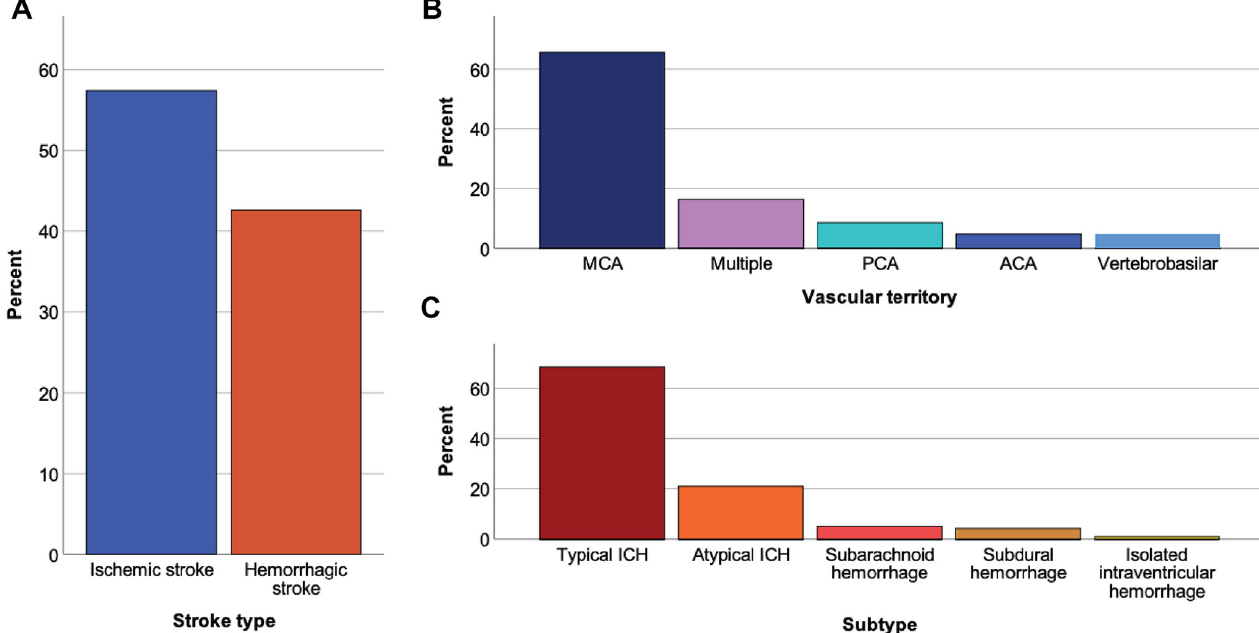
Fig 2. Radiological classification of ischemic and hemorrhagic stroke types. Panel A depicts the distribution to ischemic vs. hemorrhagic stroke as percentage of all strokes, panel B and C show distribution of vascular territories and stroke subtypes separately for ischemic ( B ) and hemorrhagic stroke ( C ). ACA, anterior cerebral artery; MCA, middle cerebral artery; PCA, posterior cerebral artery; ICH, intracerebral hemorrhage.